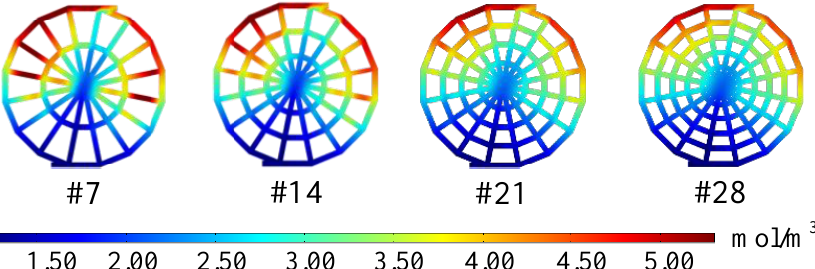
Figure 10. The water distribution of schemes # 7, #14, #21 and #28 in the cathode flow field. 3.3. Fuel Cell Performance The output voltage, current density and power density of the spider-web-type flow field were mainly affected by the joint action of the flow channels and the ribs. In PEMFC, electrons were generated in the membrane electrode assembly (MEA) and conducted to the external circuit through the ribs on the bipolar plate. The larger the contact area be- tween the ribs and the MEA, the more favorable the current conduction. However, the gas diffused as uniformly as possible to all positions of the membrane through the flow chan- nel. As the contact area between the ribs and the MEA increased, the total area of the flow channels would inevitably decrease, and the contact area between the flow channels and the gas diffusion layer would naturally decrease, which was not conducive to the full en- try of the reacting gas into the membrane to participate in the reaction to generate elec- trons. It can be seen that there was an optimal value between the total area of the ribs and the total area of the flow channels (in this paper, altering the polygonal structure or the number of layers changed the ratio of the rib area to flow channel area), which maximized the current conduction of the bipolar plate while ensuring the full diffusion of the reacting gas to the electrodes to participate in the reaction. In this section, a comparative analysis of the output voltage, current density and power density of the spider-web-type flow field was performed to determine this optimal configuration, which in turn determined the polygonal structure and the number of layers under this configuration. Figure 11 shows the polarization curves and power density curves of schemes #1 to #7.